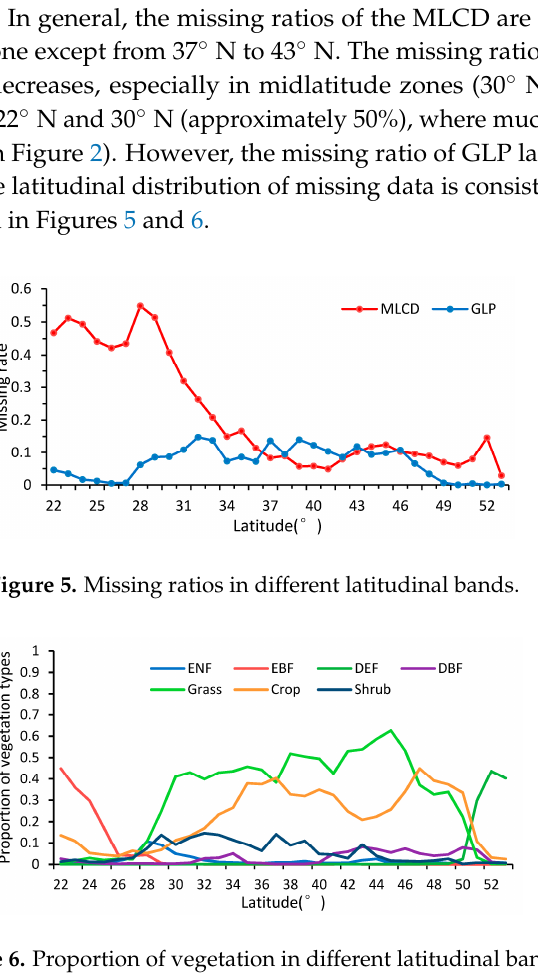
Figure 4. Missing ratios in different vegetation types.